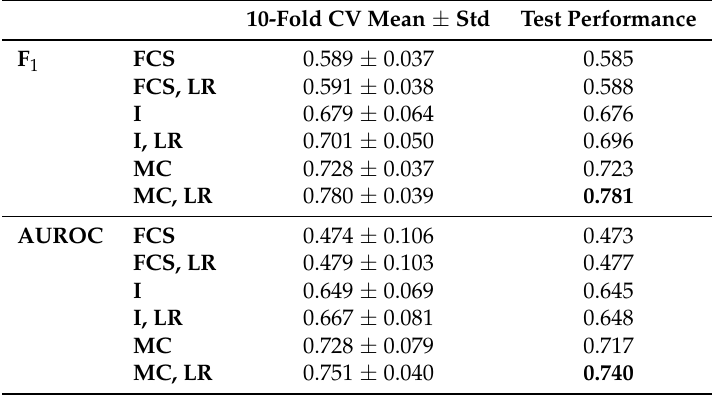
Table 3. Performance of different imputation strategies. Abbreviations: full conditional specification (FCS), lagged response (LR), indicators (I), missingness count (MC). Our method is the combination MC, LR. The highest test performance is shown in bold.